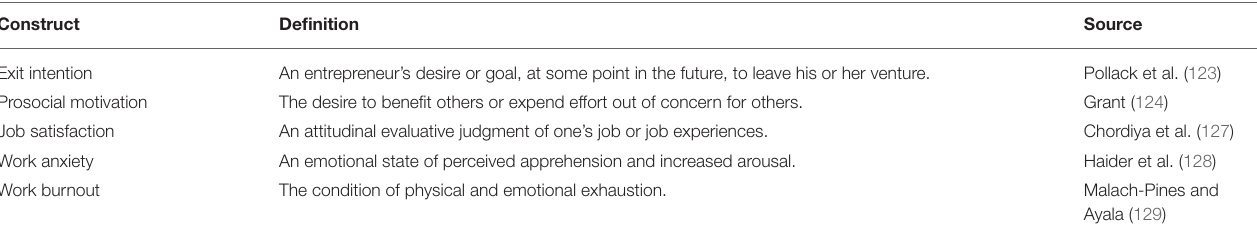
TABLE 2 | Operational definition.